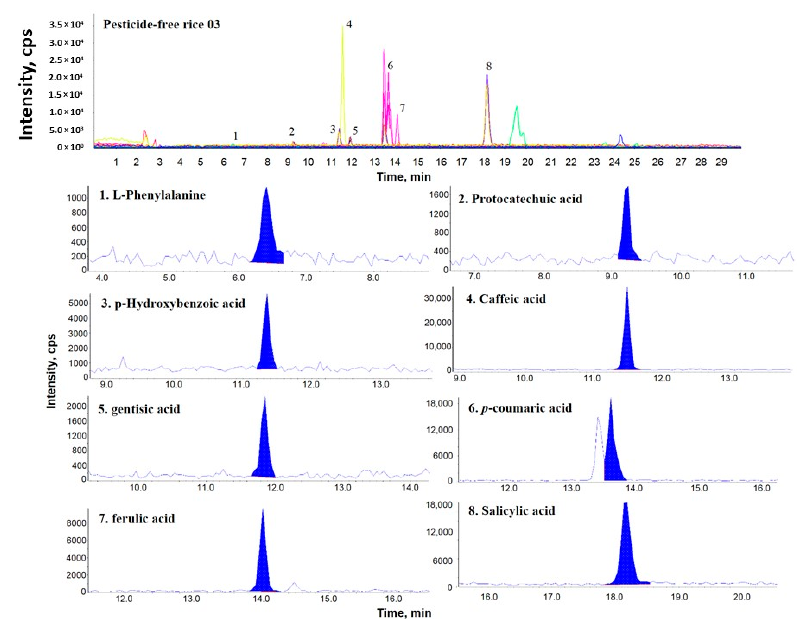
Figure 3. Representative MRM ion chromatogram of pesticide-free rice (PFR)-03 and the corresponding extracted ion chromatograms of the detected phenolic compounds.